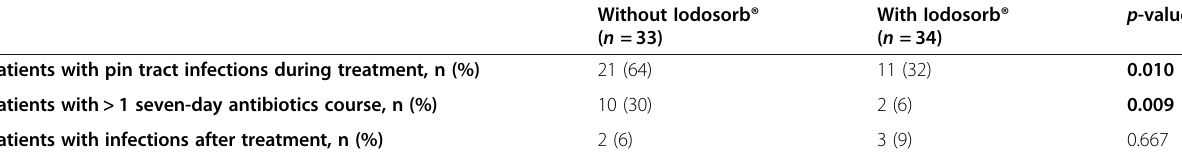
p -value Without Iodosorb® With Iodosorb® ( n = 33) ( n = 34)